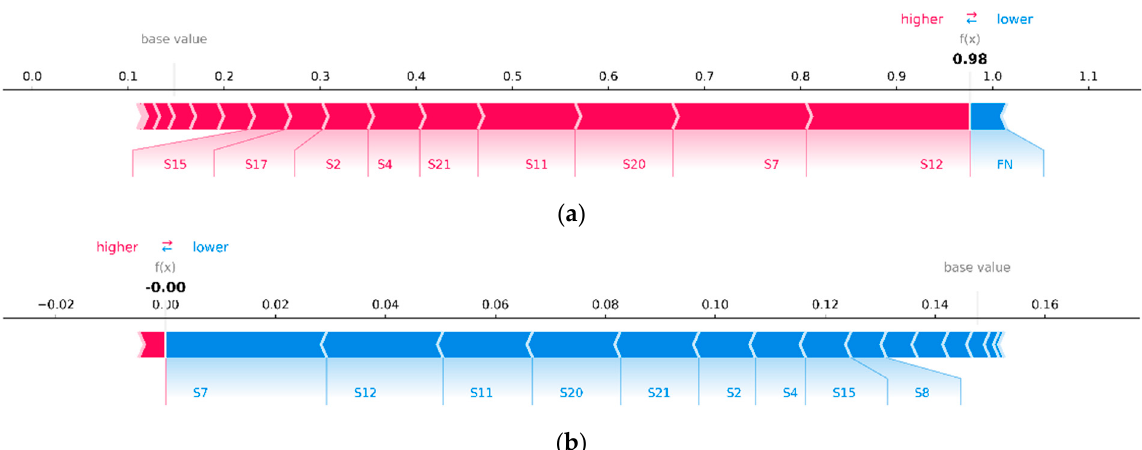
Figure 6. Contribution of all features to the probability of engine failure (red means positive contribution, and blue means negative).